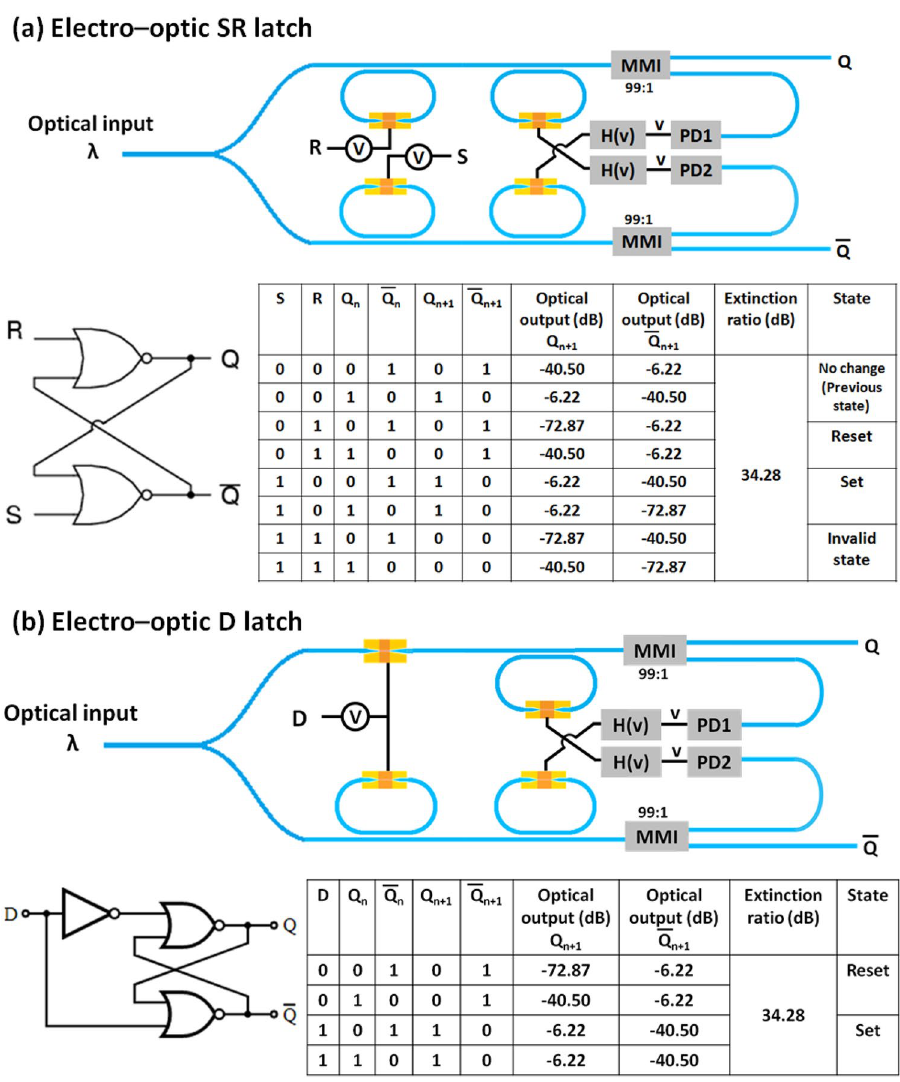
Figure 7. Electro-optic configurations, graphical symbol, and truth table of a: ( a ) SR latch circuit, and ( b ) D latch circuit. Where, PD and H(v) represents the photodetector and conditional electronic circuits respectively. H(v) generates necessary voltage pulse with different amplitude and duration for amorphorization and crystallization depending on the photodetector